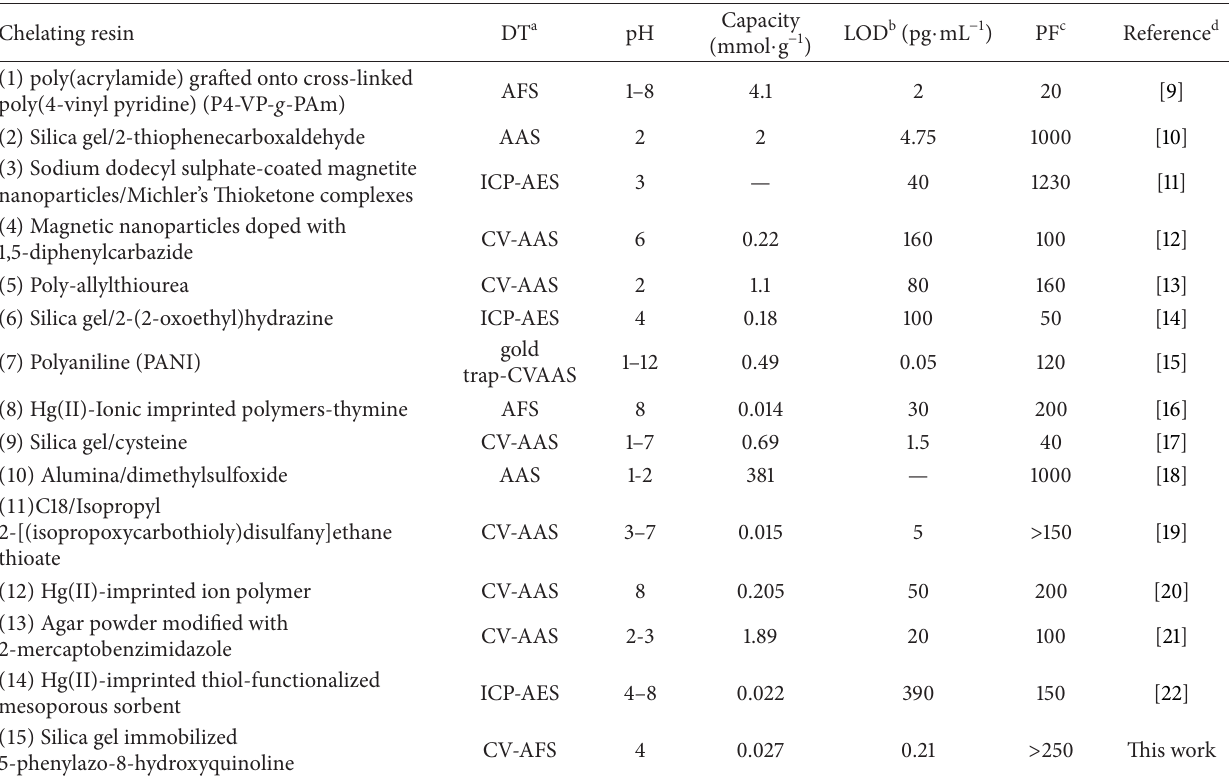
Table 12: Comparison of figures of merits for different preconcentration methods for Hg(II)